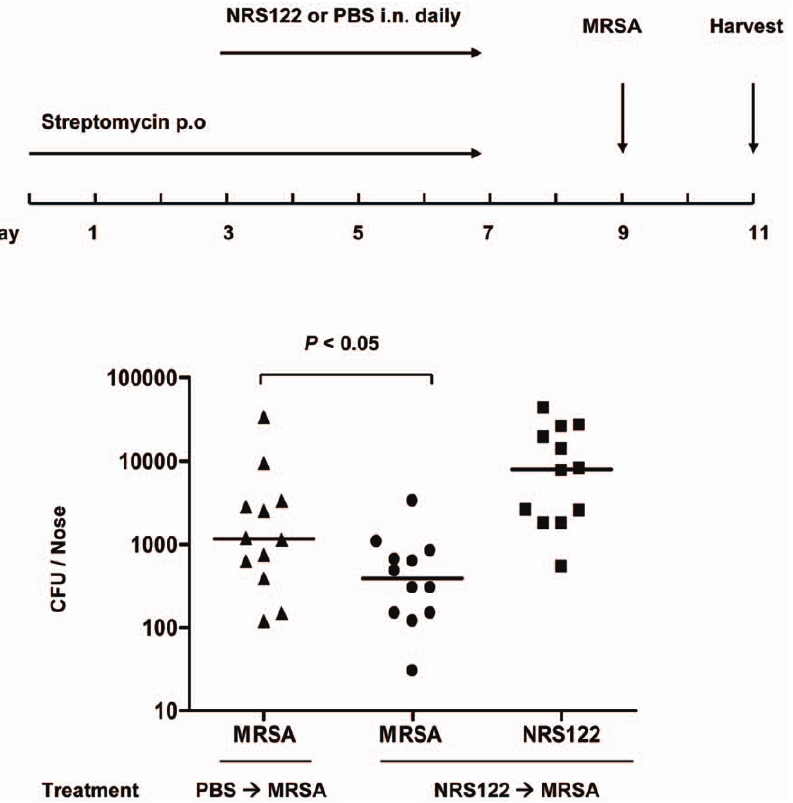
Figure 2. Pre-colonization of mouse nares with S.epidermidis NRS122 reduces colonization with MRSA. Top panel: Experimental design. Bottom panel: Comparison of MRSA colonization in mice given streptomycin water and pretreated with either PBS or S. epidermidis NRS122. Streptomycin-resistant strains of MRSA and NRS122 (5 6 10 8 CFU) were applied at each inoculation. Bars in the graph represent the median CFU of each experimental group. Mean bacterial counts were 4715 CFU of MRSA in the control group, and 673 CFU of MRSA and 12953 of NRS122 in the S. epidermidis NRS122 pretreated group.